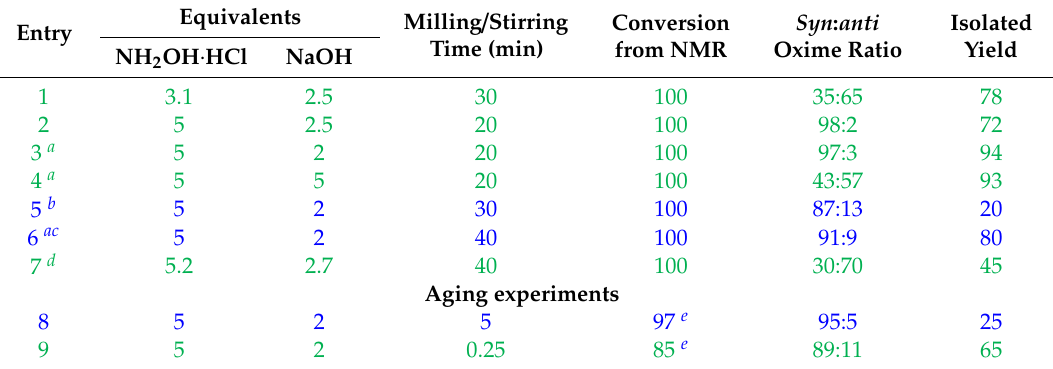
Table 1. Basic experimental conditions used in the synthesis of 1-methoxyindole-3-carboxaldehyde oxime and the reactions outcome. The di ff erent reaction conditions are marked by color: green color: ball milling in Pulverisette 7 premium line mill, WC vessel (80 mL) and balls (in most cases 18 pieces, ∅ 10 mm, weight of 1 ball 7.7 g); blue color: ball milling in Pulverisette 6 mill, agate vessel (250 mL) and balls (50 pieces, ∅ 10 mm, weight of 1 ball 2.4 g). The ideal experiment is marked in bold. The